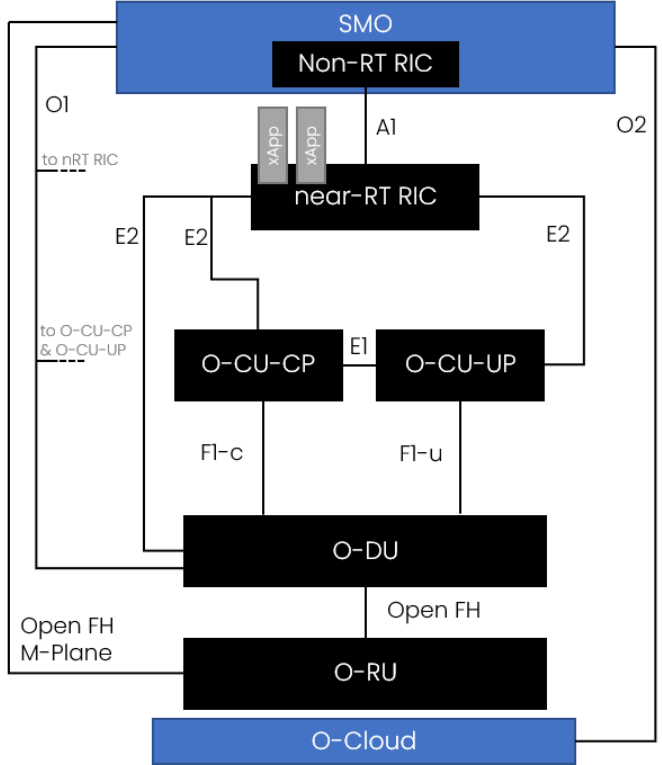
Figure 1. O-RAN Architecture.